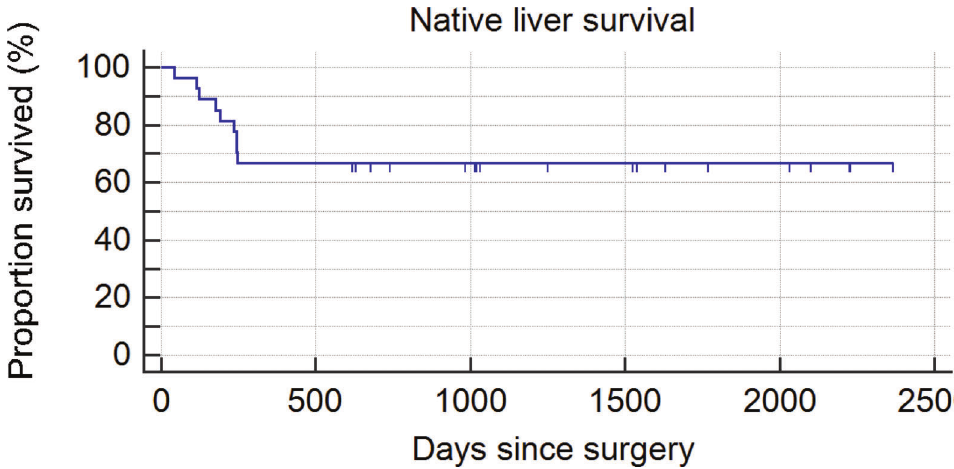
Figure 4 - Kaplan-Meier native liver survival curve (2010-2016 /